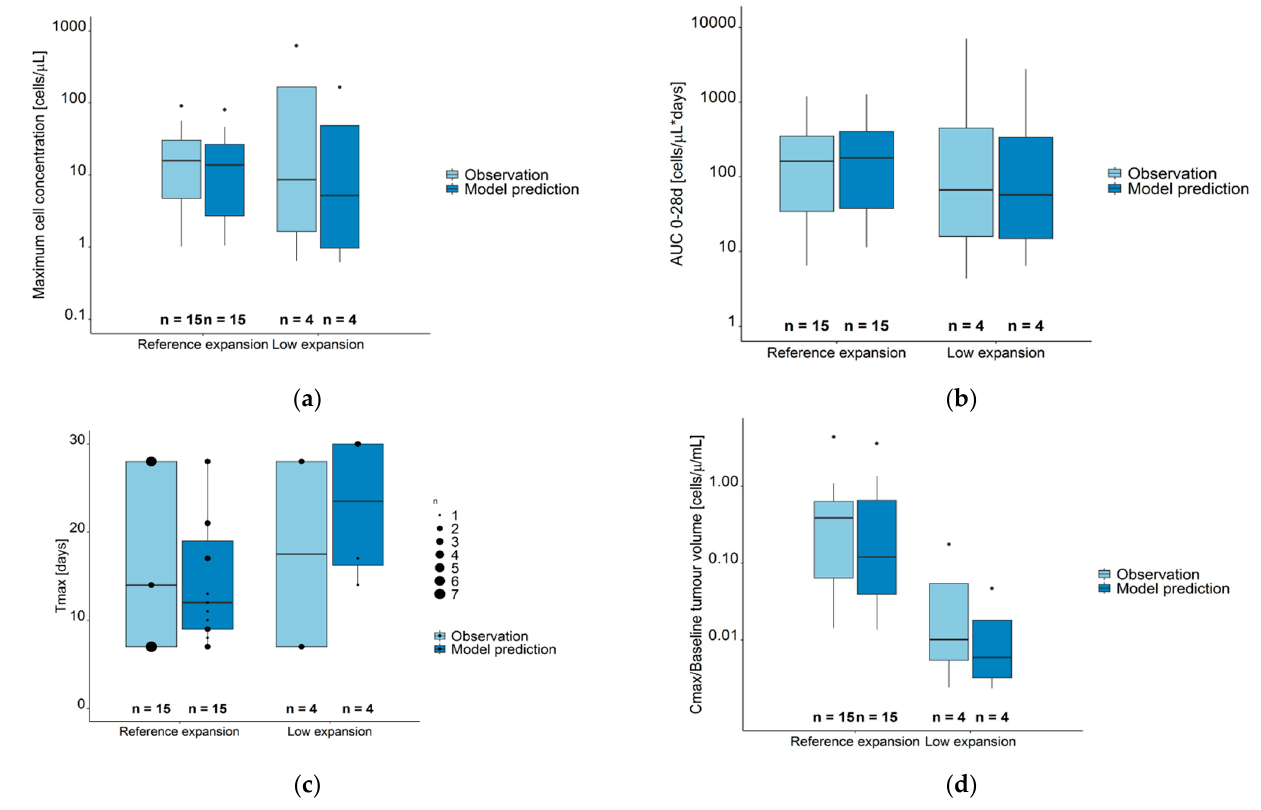
Figure 5. Figure 5. Observed (light blue boxes) and model predicted (dark blue boxes) CAR-T cell kinetic parameters for the sum of all CAR-T cell populations. ( a ) Maximum cell concentration (Cmax). ( b ) Area under the concentration–time curve from day 0–28 (AUC 0–28d ). ( c ) Time at maximum concentration (days); data points of differences sizes mark the number of observations/predictions at different time points. ( d ) Cmax/Baseline metabolic tumor volume (cells µ L − 1 mL − 1 ). Legend—Boxes: interquartile range (IQR) including median; whiskers: range from hinge to lowest/highest value within 1.5 IQR; points: data outside whisker. Abbreviations—Tmax: time at maximum CAR-T cell concentration; AUC 0–28d: area under the concentration–time curve from days 0–28, Cmax: maximum CAR-T cell